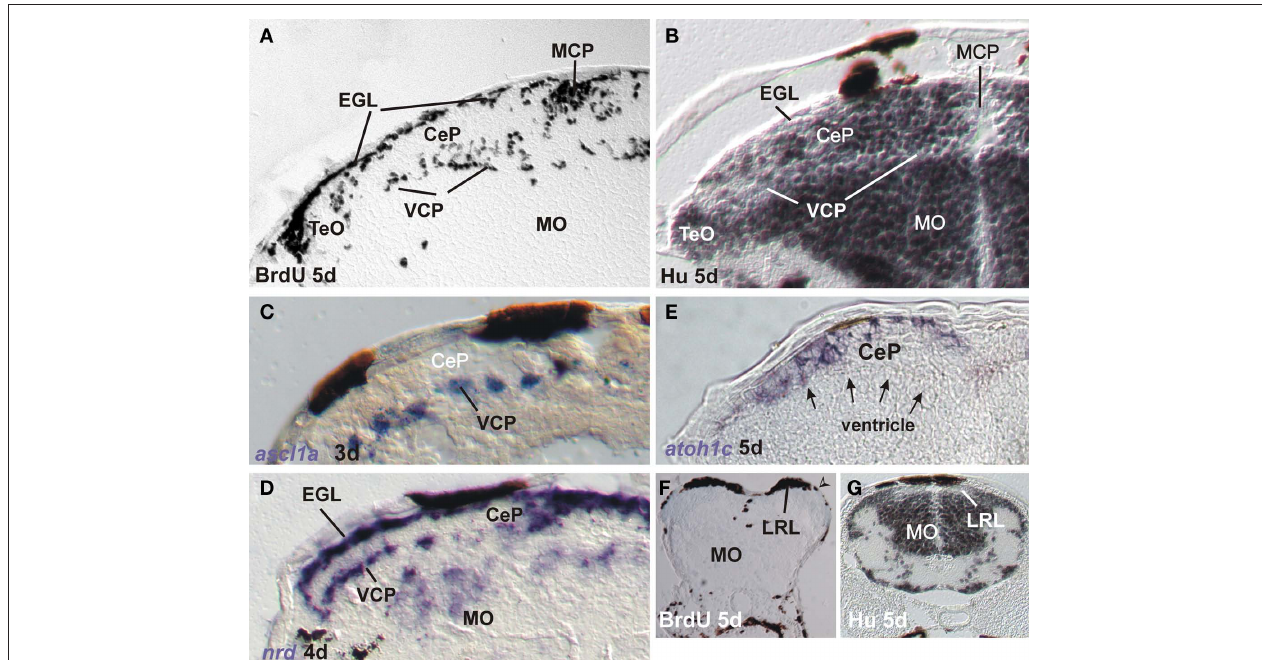
cerebellar expression of bHLH atoh1c . Note position of ventricle (arrows). (F) Proliferation at LRL level shown with BrdU saturation label. Note position of ventriculo-pial transition (arrowhead). (g) Differentiation at LRL level shown with Hu immunohistochemistry. Note Hu-free LRL. Both modified from Mueller and Wullimann (2005). CeP, cerebellar plate; EGL, external granular (or germinative) layer; IO, inferior olive; LRL, lower rhombic lip; MCP, middle cerebellar proliferation; MO, medulla oblongata; TeO, tectum opticum; VCP, ventral (or ventricular) cerebellar proliferation (ventricular germinal matrix).